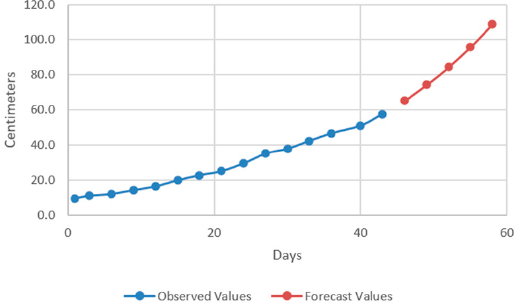
Figure 9. The evolution of basil shoot height in AH experimental variant.